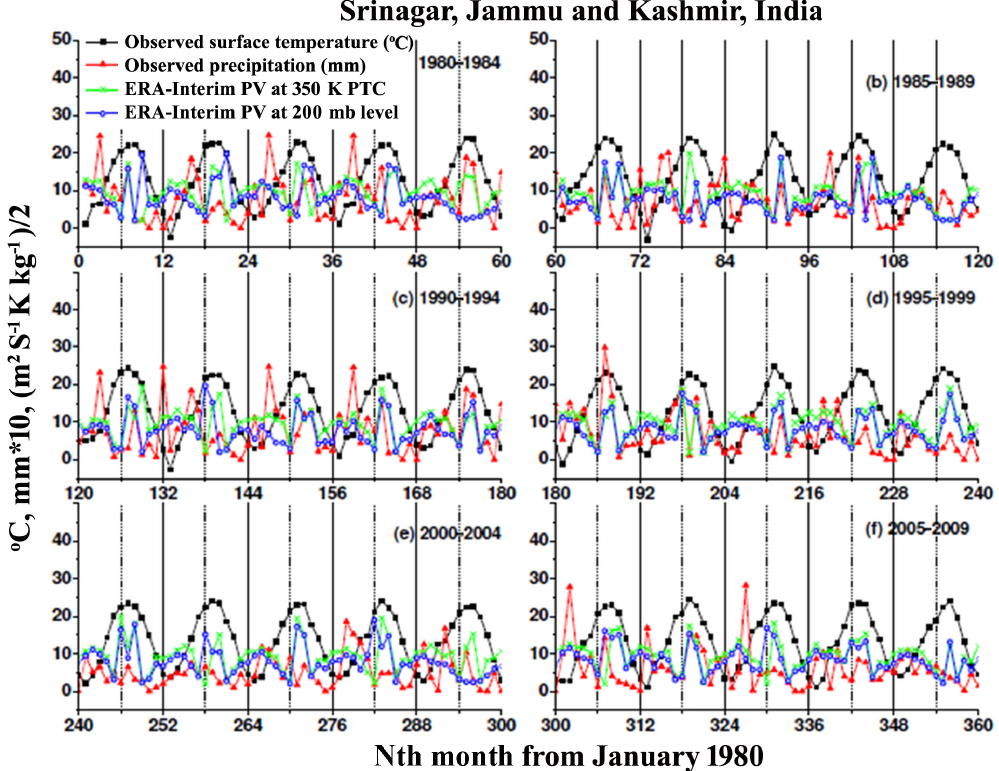
Figure 7. Observed monthly averaged surface temperature and precipitation as well as ERA-interim potential vorticities at the 350K potential temperature and 200hPa pressure surfaces for the Srinagar station during the years